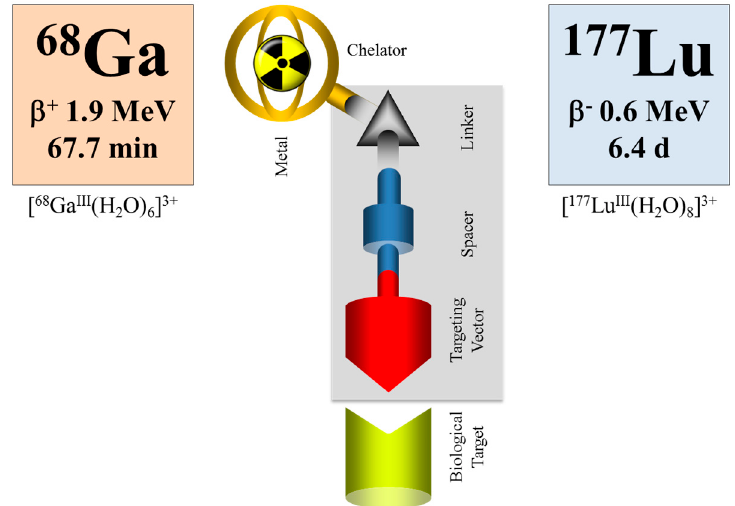
Figure 16. Schematic illustration of the class of tumor targeting vectors (e.g., peptides) conjugated to a chelator, which is able to coordinate a diagnostic and a therapeutic radiometal (e.g., 68 Ga and 177 Lu). The typical chelator is DOTA, and for several tracers, there exists a sophisticated linker and spacer chemistry.